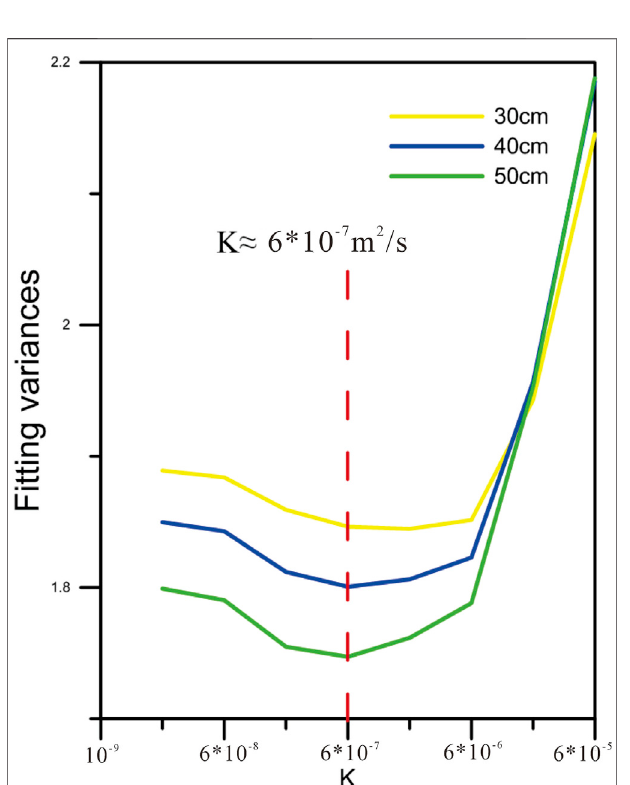
FIGURE2| Fitted κ -value(forbettervisualization,onlythe fi rsteight data are selected for the horizontal coordinates of the plot, which do not affect the results).